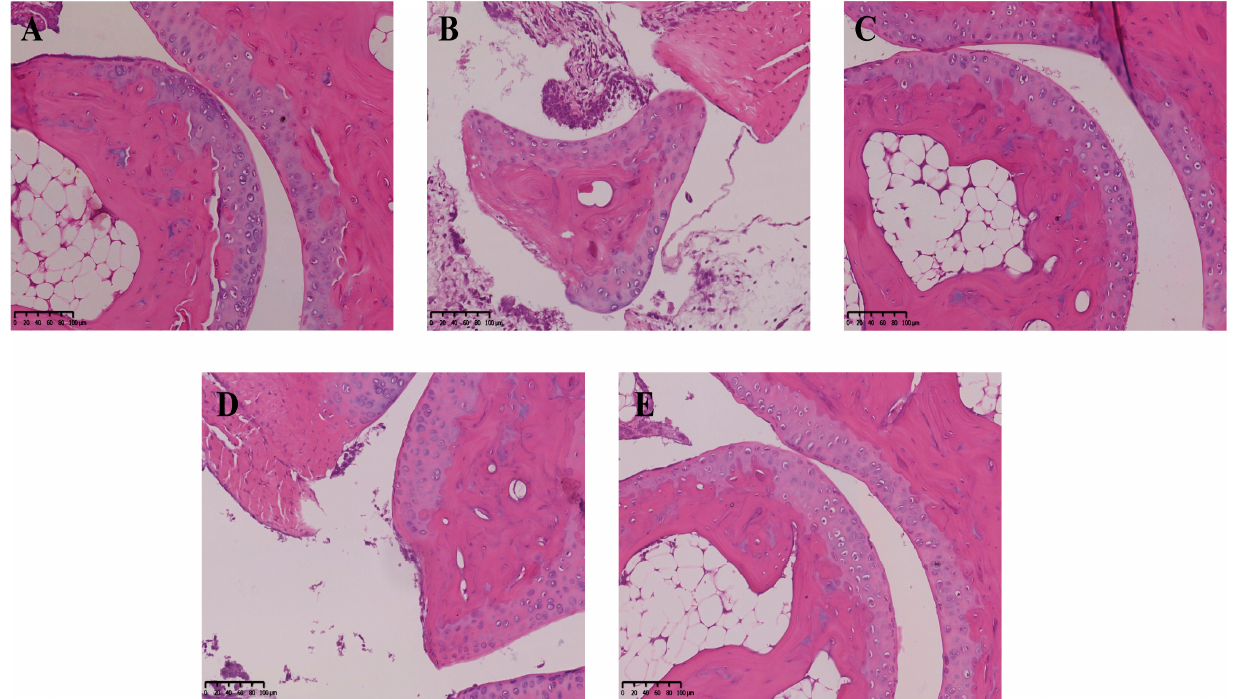
Figure 8. Effect of neoastilbin on MSU-induced inflammatory infiltration in ankle joints: ( A ) control group, ( B ) MSU group, ( C ) colchicine group, ( D ) neoastilbin low-dose group, and ( E ) neoastilbin high-dose group.